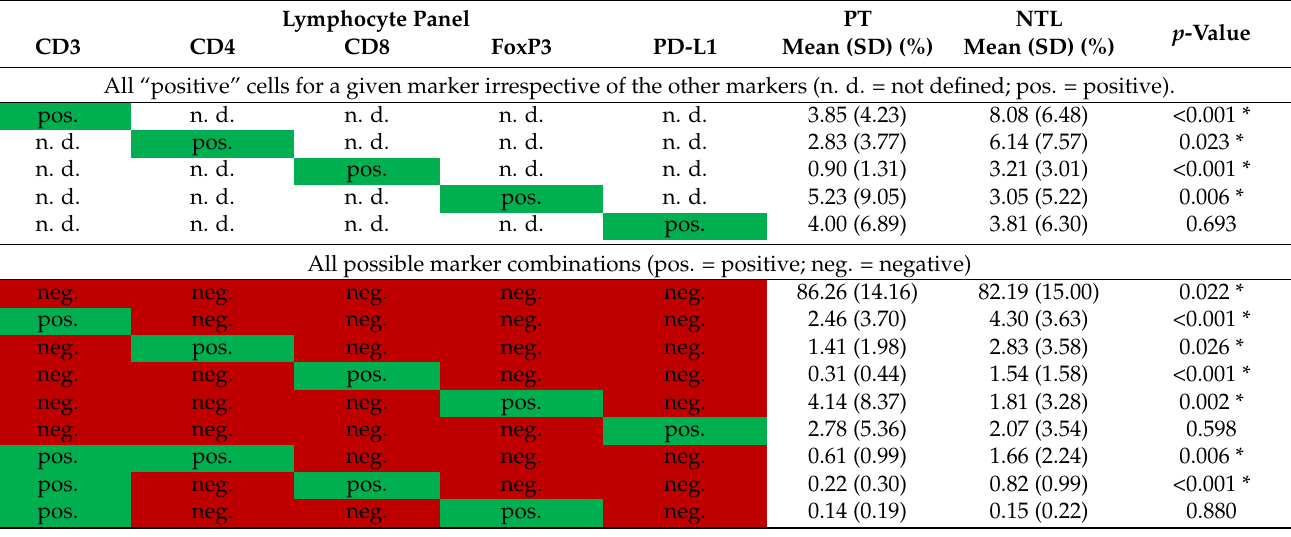
neg. <0.001 * neg. pos. neg. 0.14 (0.19) 0.15 (0.22)